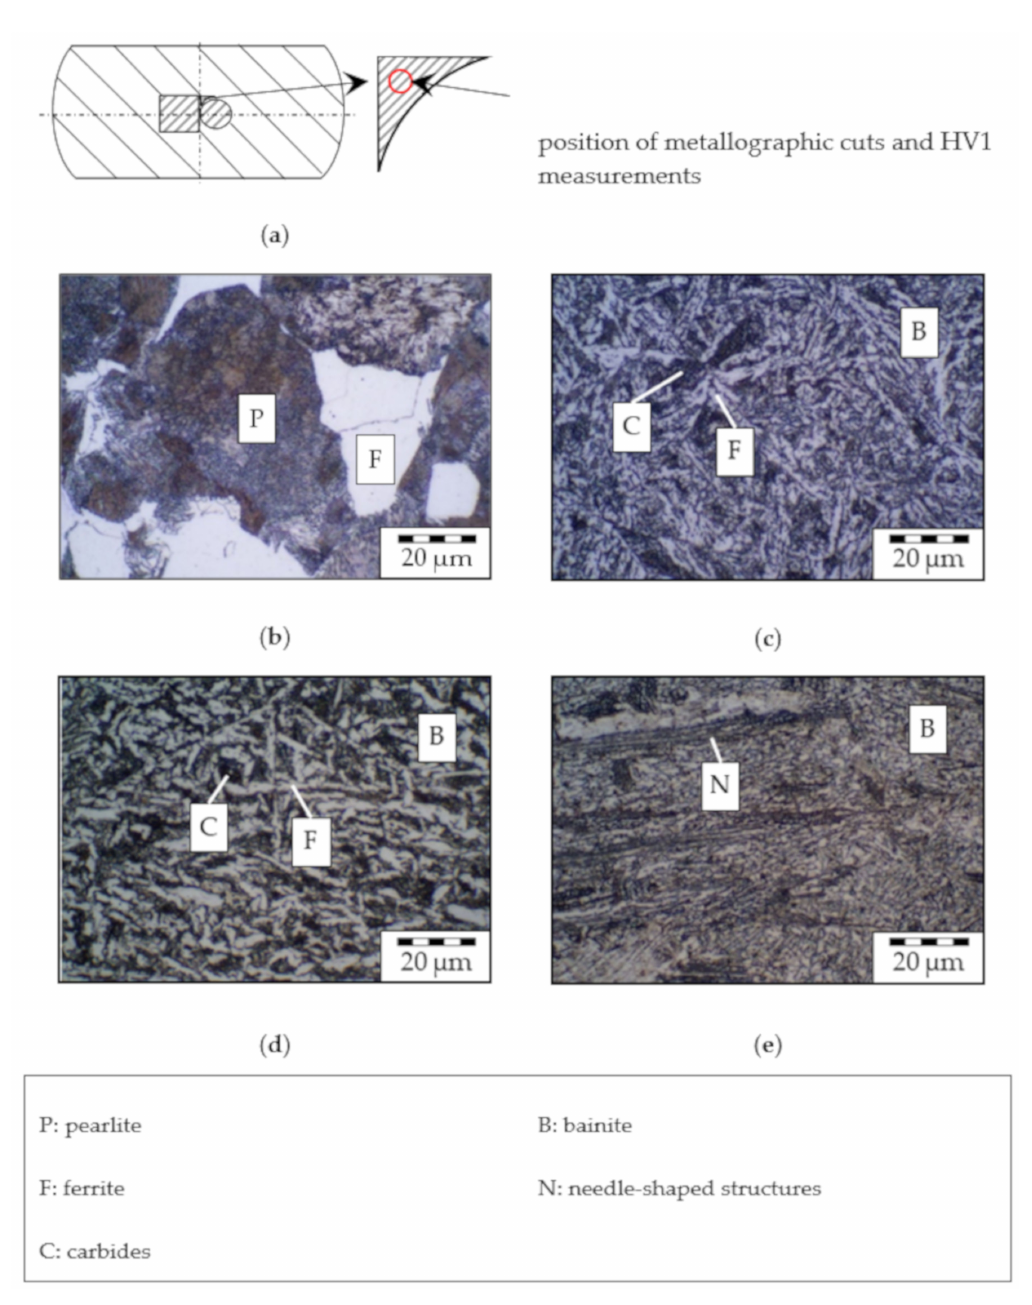
Figure 4. ( a ) Position of metallographic cuts and HV1 measurements, micrographs: ( b ) initial state [22]; ( c ) reference route and di ff erent thermomechanical treatment (TMT) routes (( d ) 0.3 + 0.3, lh; ( e ) 0.3 + 0.3, hl). Etched with nitric acid